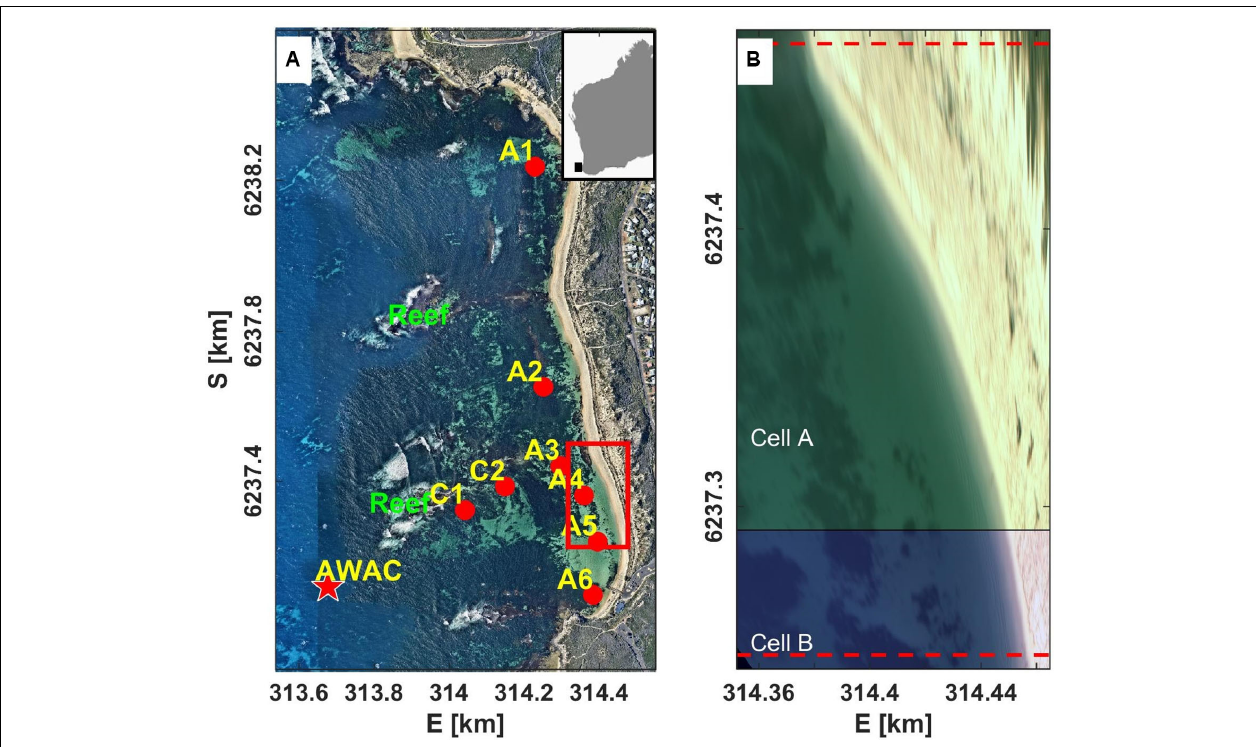
FIGURE 1 | (A) Aerial photo of the study area with 2 main offshore reefs around 600 m from the shoreline (source: www.nearmap.com). The red star denotes the location of the AWAC, the red circles denote locations of the pressure gauges. The red rectangle is the coverage area of video camera. The insert at top right corner shows the location of Gnarabup beach at the southwest coast of Western Australia. (B) The coverage area at the south of the beach from the image rectification process (red box in Figure 1A ) used in this study and the 2 parts, i.e. (A,B) , at Cell 3 (see Figure 7B for the description) separated by a black line that represents the location of a node (center of beach rotation). The red dashed lines denote the border of 5 m farthest points used to identify shoreline rotation in Figure 7C ). The coordinate system is in UTM (Universal Transverse Mercator) Zone